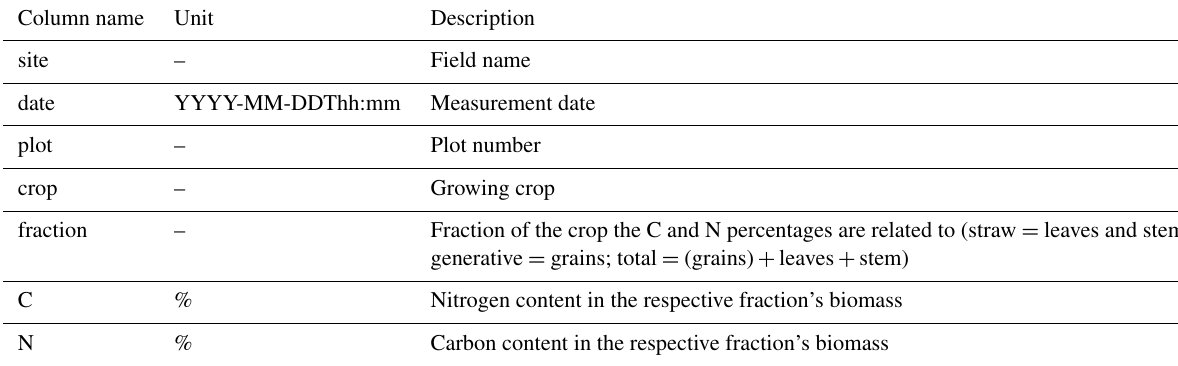
Table 15. Determined variables and description of carbon and nitrogen content data of the crop biomass